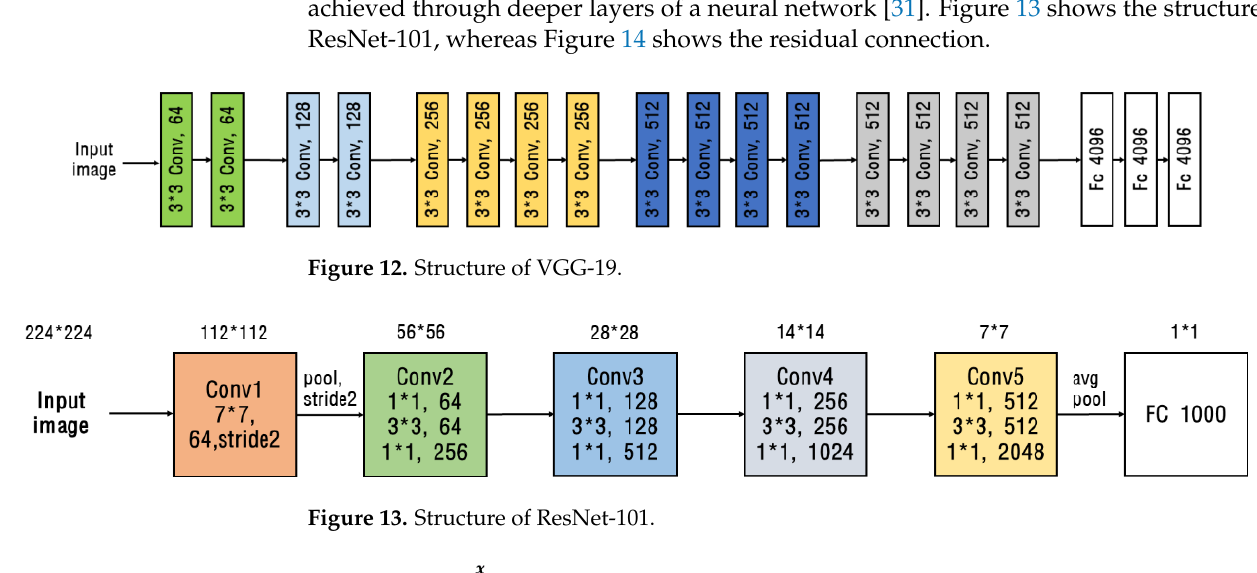
Figure 11. Inception module. Figure 12. Structure of VGG-19.